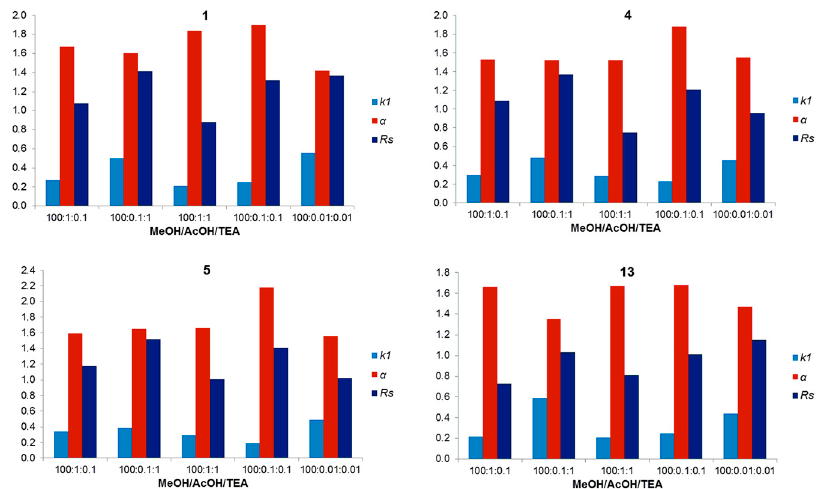
Figure 4. Effect of the different proportion of AcOH and TEA in MeOH on chromatographic parameters k 1 , α and R S for analytes 1 , 4 , 5 and 13 .